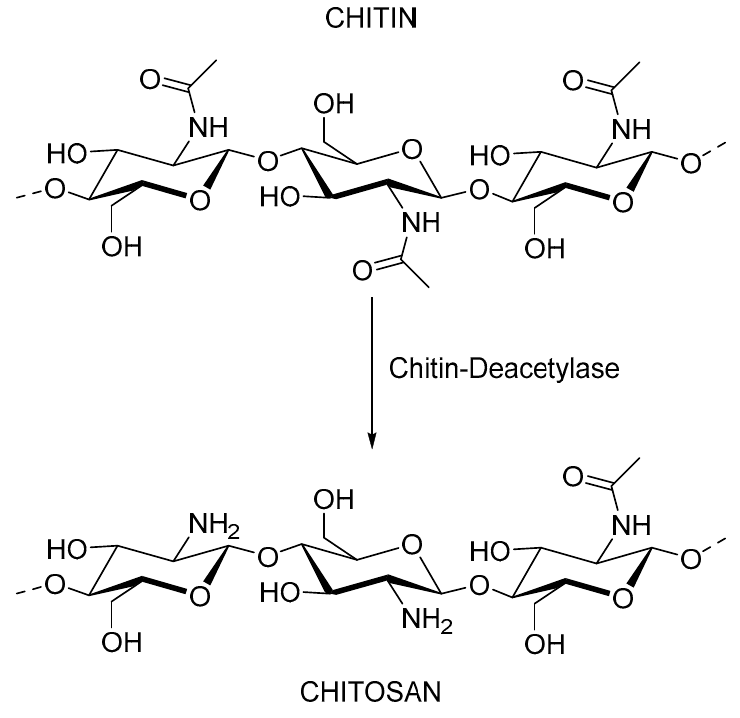
Figure 5. Chitin and chitosan structure.